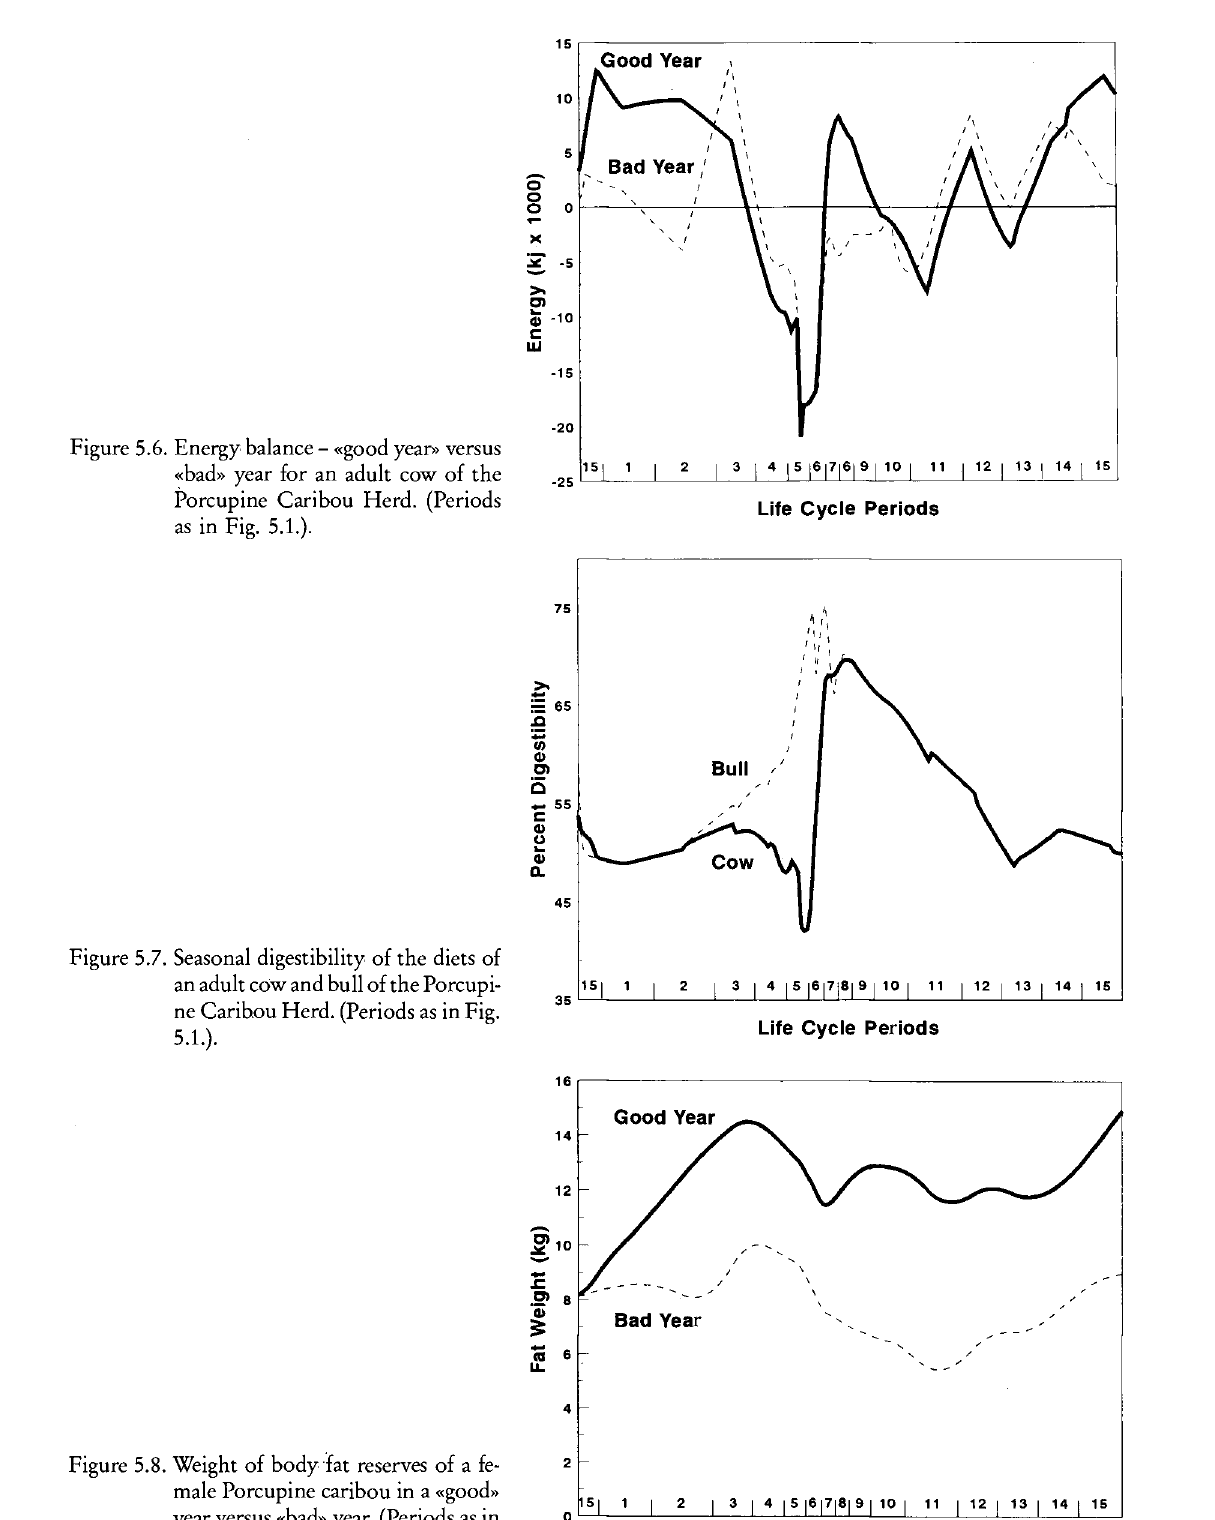
Figure 5.8. Weight of body fat reserves of a fe male Porcupine caribou in a «good» year versus «bad» year. (Periods as in Fig.